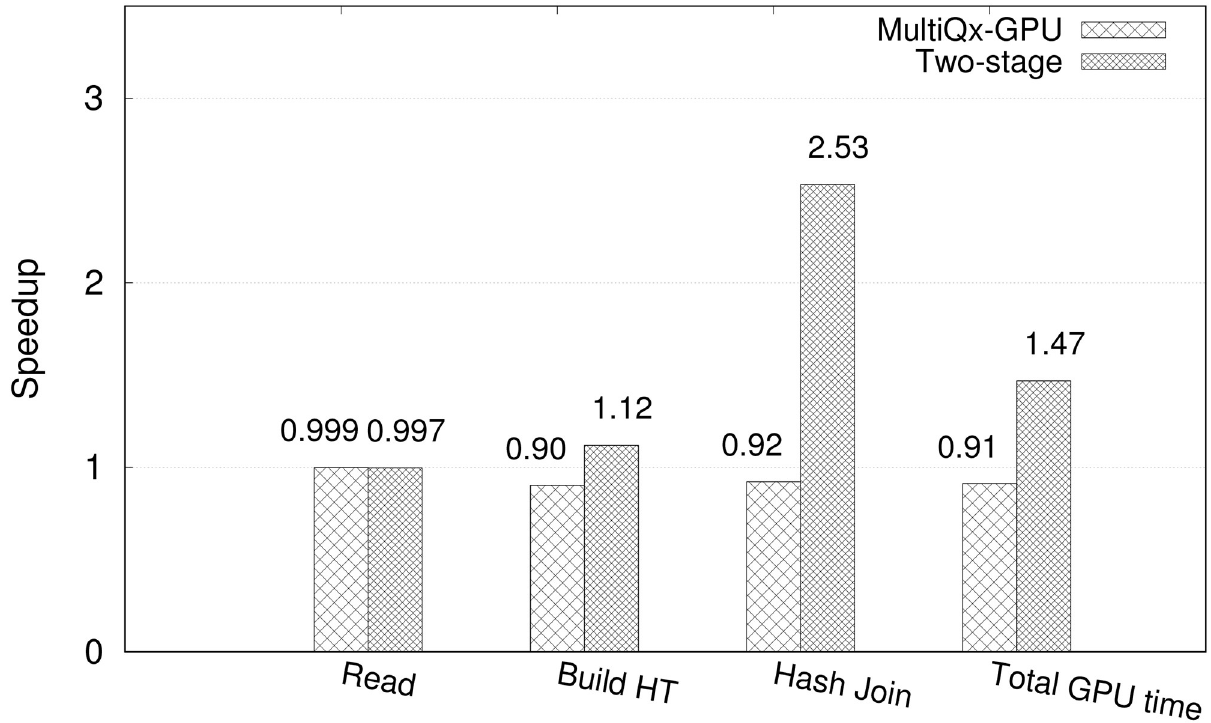
Fig 7. Speedup of two-table hash join GPU operations that MultiQx-GPU Optimization and Two-stage Model over sequential solution.